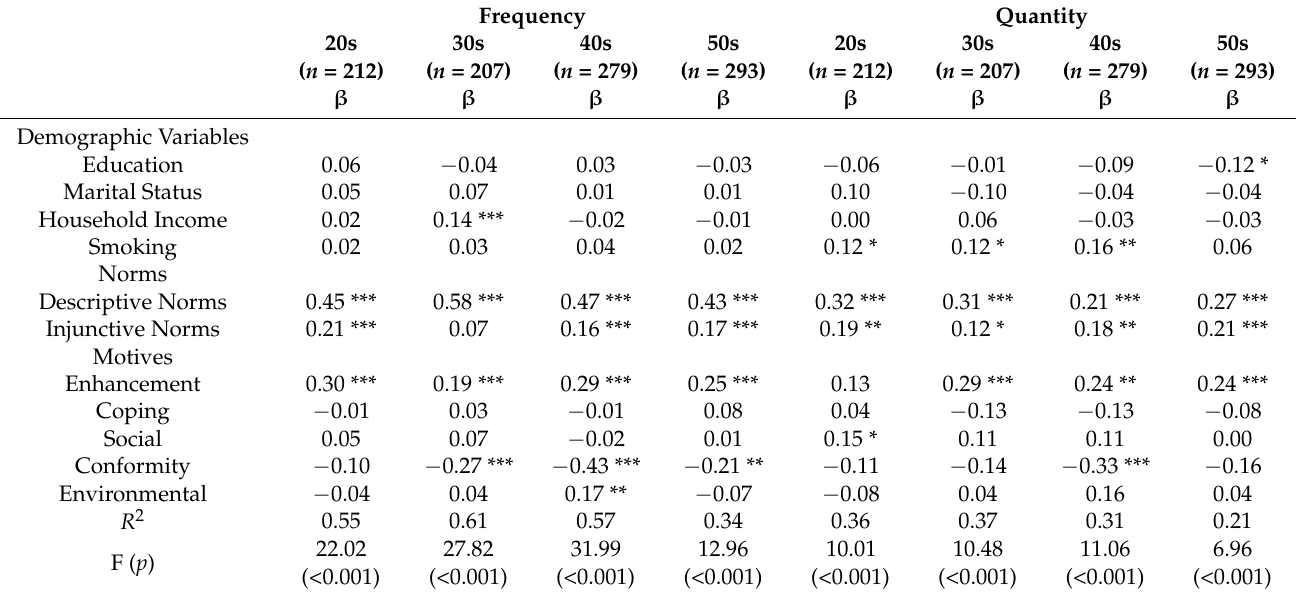
Table 4. Multiple regression analyses predicting drinking frequency and quantity across age